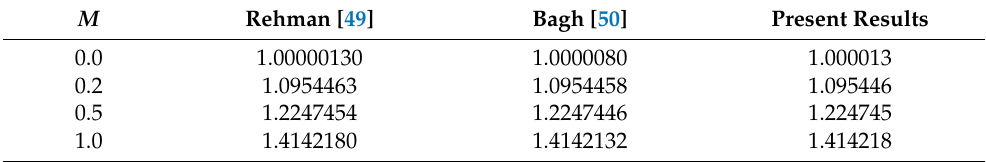
Table 1. Comparing the current numerical findings for M when and all others parameter are zero. M Rehman [49] Bagh [50]